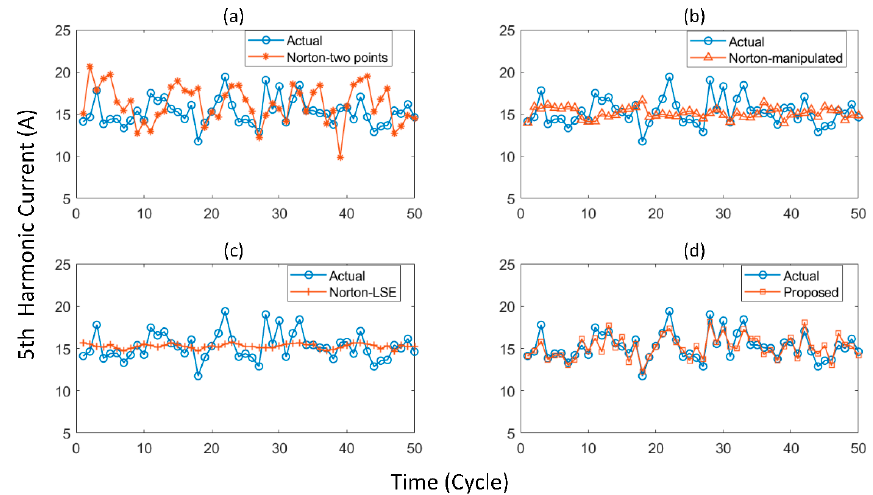
Figure 11. Comparisons of 5th harmonic current between actual measurement and estimations by Norton-two point method ( a ), Norton-manipulated method ( b ), Norton-LSE method ( c ) and the proposed method ( d ).